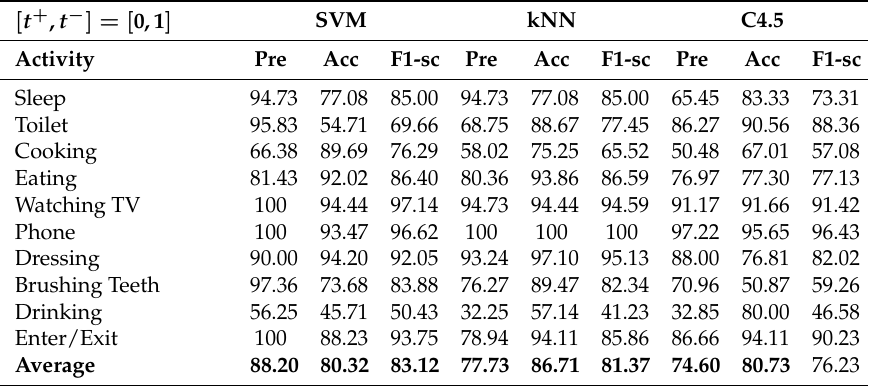
Table 3. Results with baseline features: precision (Pre), recall (Rec) and F1-score